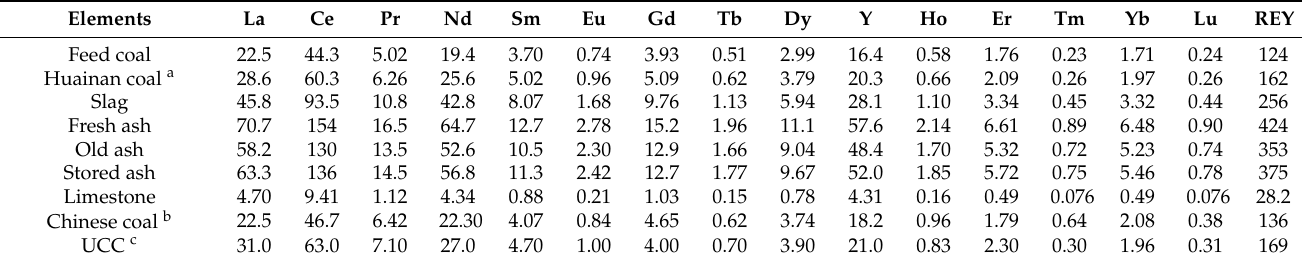
Table 5. Concentrations of REY in feed coal and its by-products from the TY power plant (units: mg/kg on an air-dried